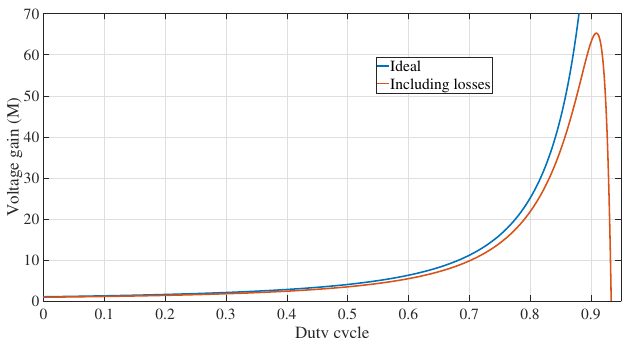
Figure 11. Comparison between the ideal gain and the gain including the power losses.